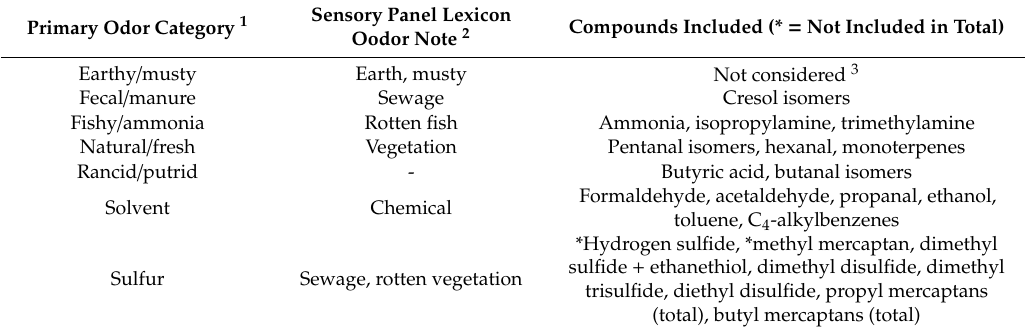
Table 8. Primary odor categories for wastewater, their correlation with the sensory panel’s informal odor notes, and the most significant odor-active compounds detected using